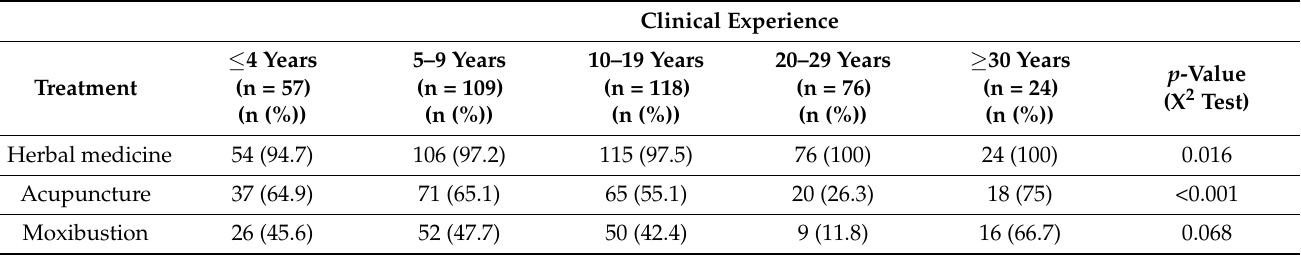
Table 4. Utilization patterns of main treatment methods by clinical experience (N =